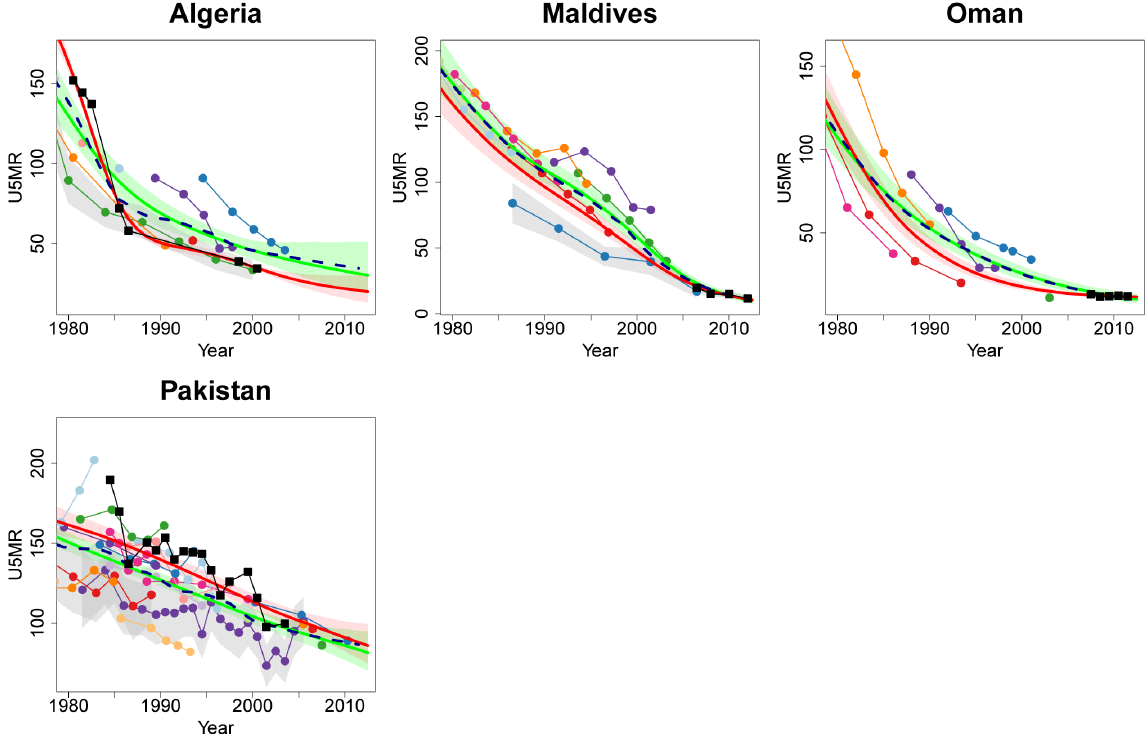
Figure 8. Comparison of U5MR estimates for Algeria, Maldives, Oman and Pakistan, where the inclusion of the data quality model resulted in estimates that are closer to VR data. Estimates compared are from UN IGME 2013 (solid red line with 90% credible intervals given by the shaded regions), B2 fit to 2013 database (solid light green line with 90% credible intervals given by the shaded regions), default Loess fit to 2013 database (dashed dark blue line). Connected dots denote data from the UN IGME 2013 database and gray shaded areas around series of observations represent the sampling variability in the series (quantified by two times of the sampling standard errors). VR data is denoted by connected black squares. Excluded data series and detailed information on all data series are displayed in Figure S1.